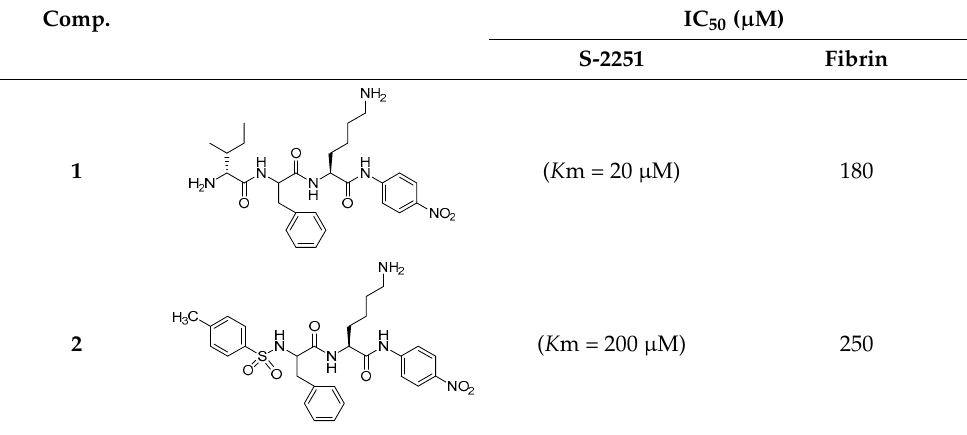
Table 1. Plasmin (Plm) inhibitory activity of compounds 1 – 3 [28]. Comp.